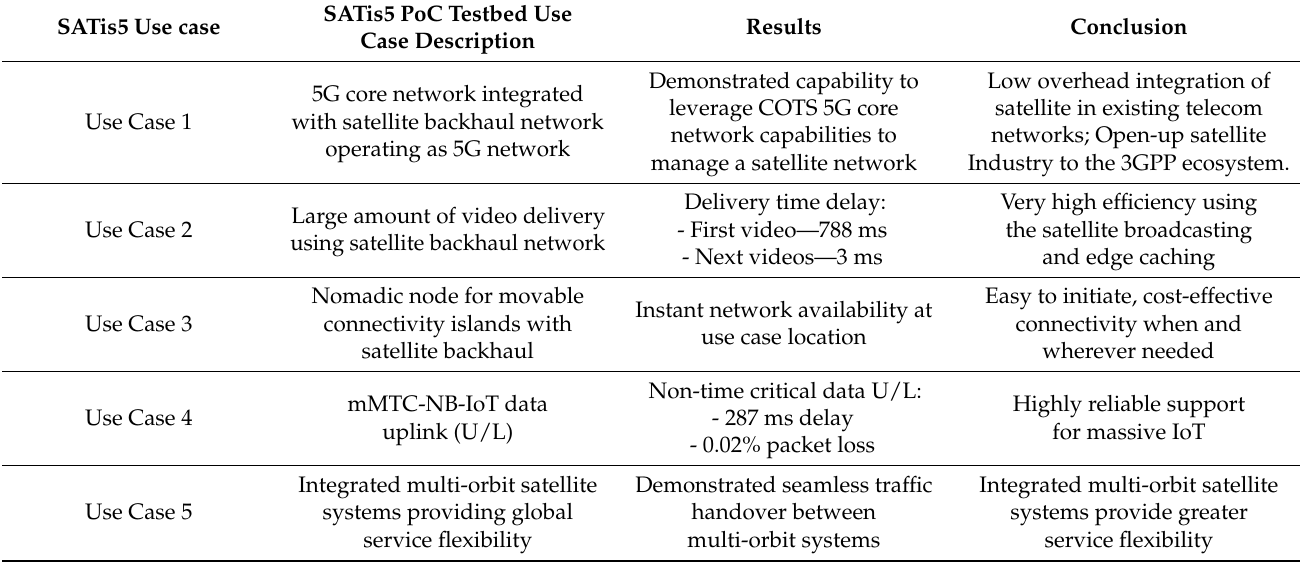
Table 4. A Summary of Some Key SATis5 PoC Testbed